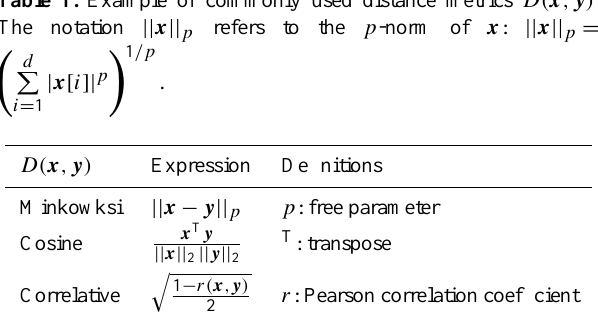
Table 1. Example of commonly used distance metrics D( x , y ) . The notation || x || p refers to the p -norm of x : || x || p =